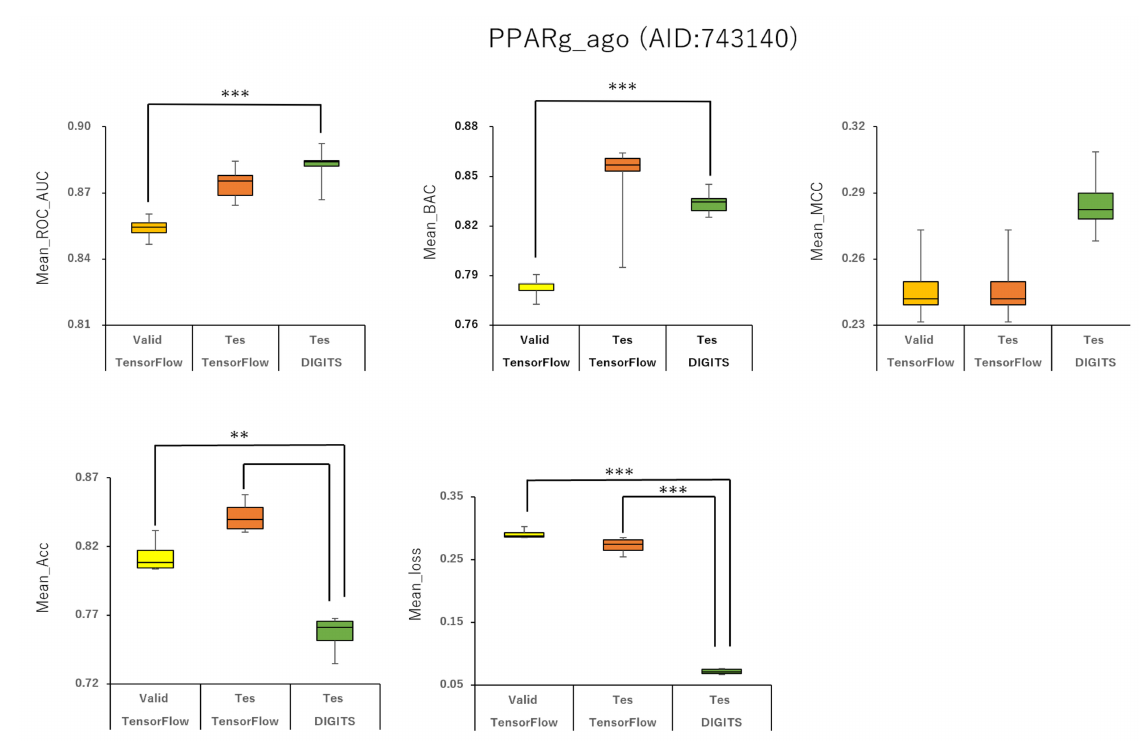
Figure 5. Means ROC_AUC, means BAC, means MCC, means Acc, and means loss of PPARg_ago (AID:743140) in validation and test datasets in TensorFlow and test dataset in DIGITS. ** p < 0.01, *** p < 0.001 for t -test.